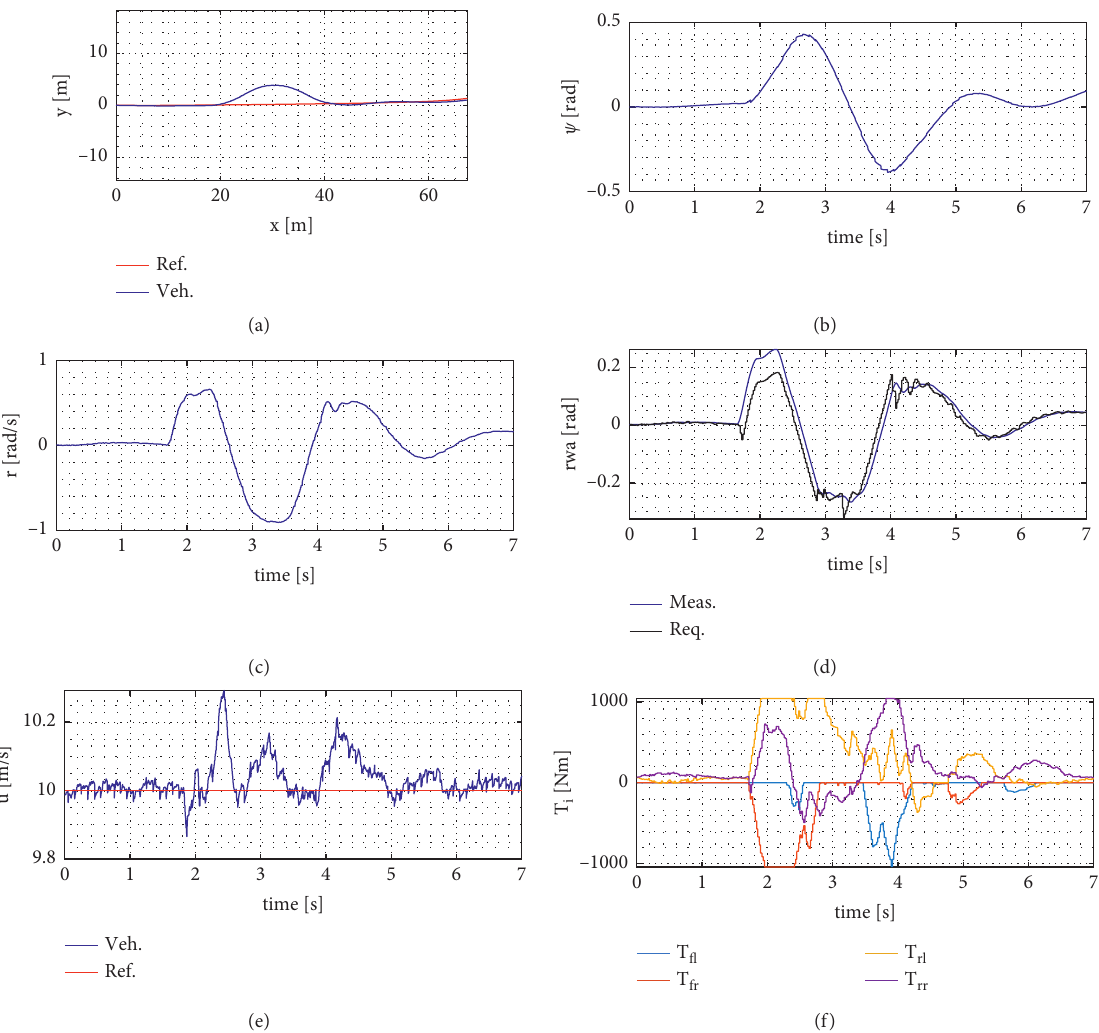
Figure 13: Override handling using cost function g F . (a) Path. (b) Heading. (c) Yaw rate. (d) Road-wheel angle. (e) Longitudinal velocity. (f) Wheel torques.